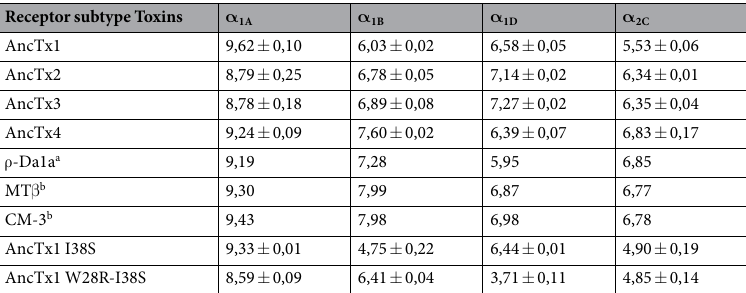
Table 1. Affinity constant (pKi ± SEM) of ρ -Da1a evolutionary pathway toxins for adrenoceptors α 1A , α 1B , α 1D and α 2C . a: [19], b: